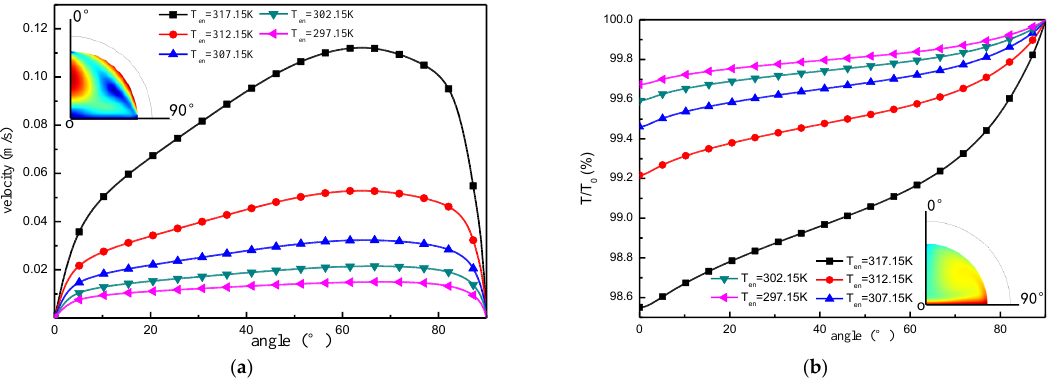
Figure 13. Variation of the physical field on the liquid surface boundary line at different ambient temperatures. ( a ) Variation in droplet surface flow rate (20 min); ( b ) Change in droplet surface temperature (20 min).